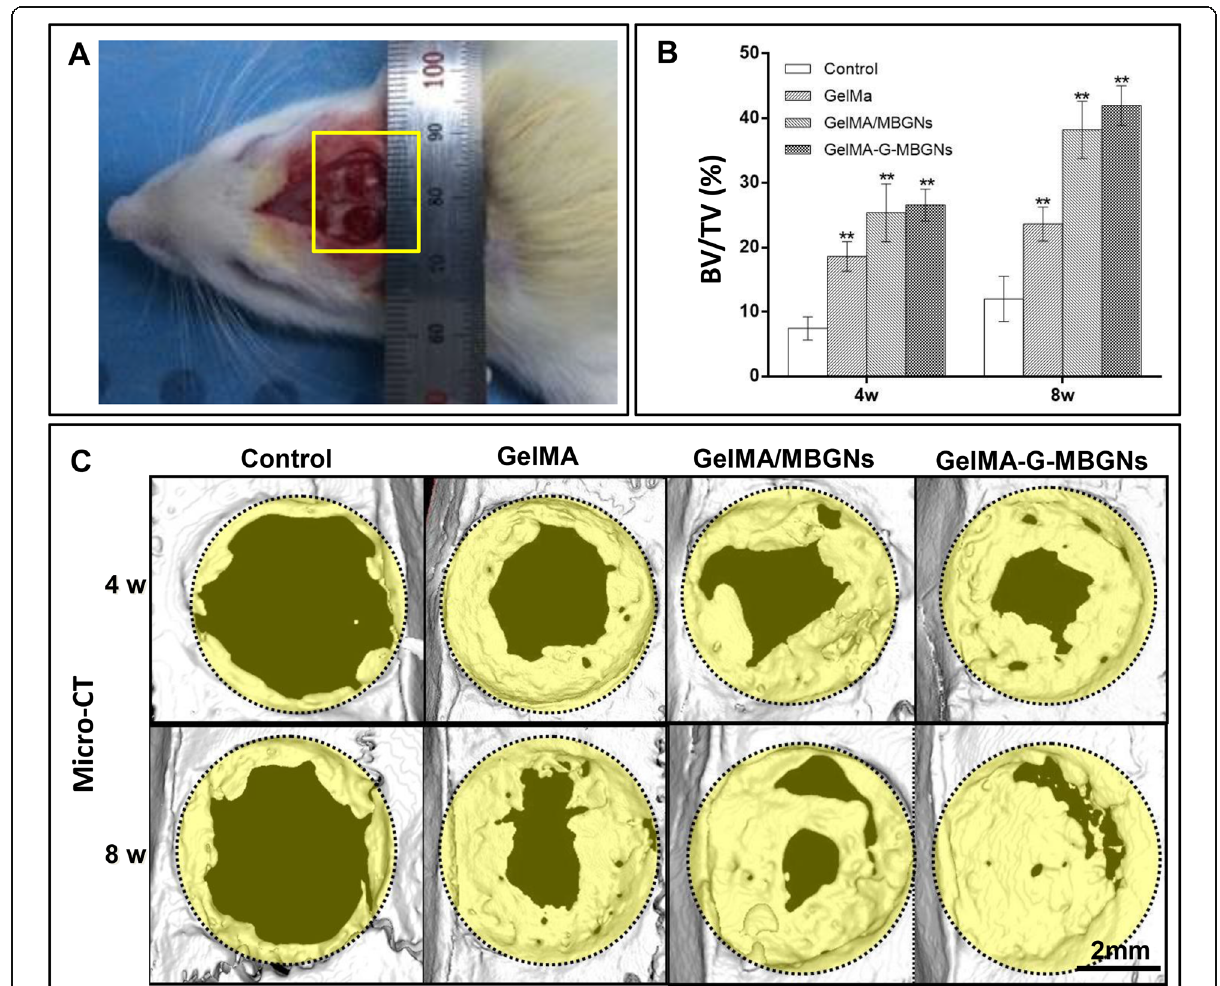
Fig. 4 a Photograph of mouse bone defect model. b - c Healing status of the injured area in the fourth and eighth weeks of each experimental group. Reproduced with permission [75]. Copyright (2017), American Chemical